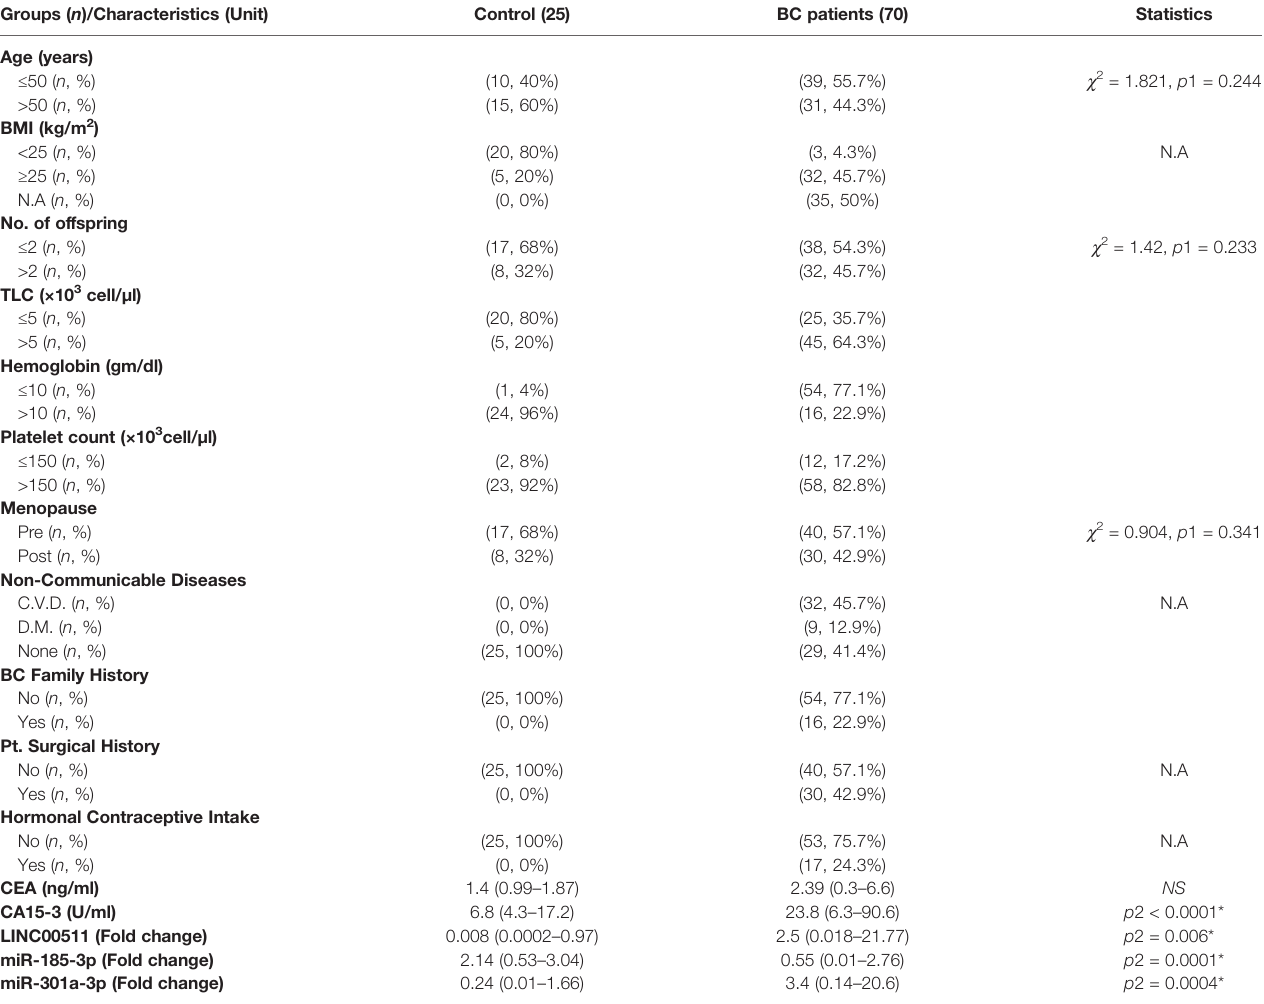
TABLE 2 | Study participants ’ clinical and demographic features and targeted ncRNA expression levels. Groups ( n )/Characteristics